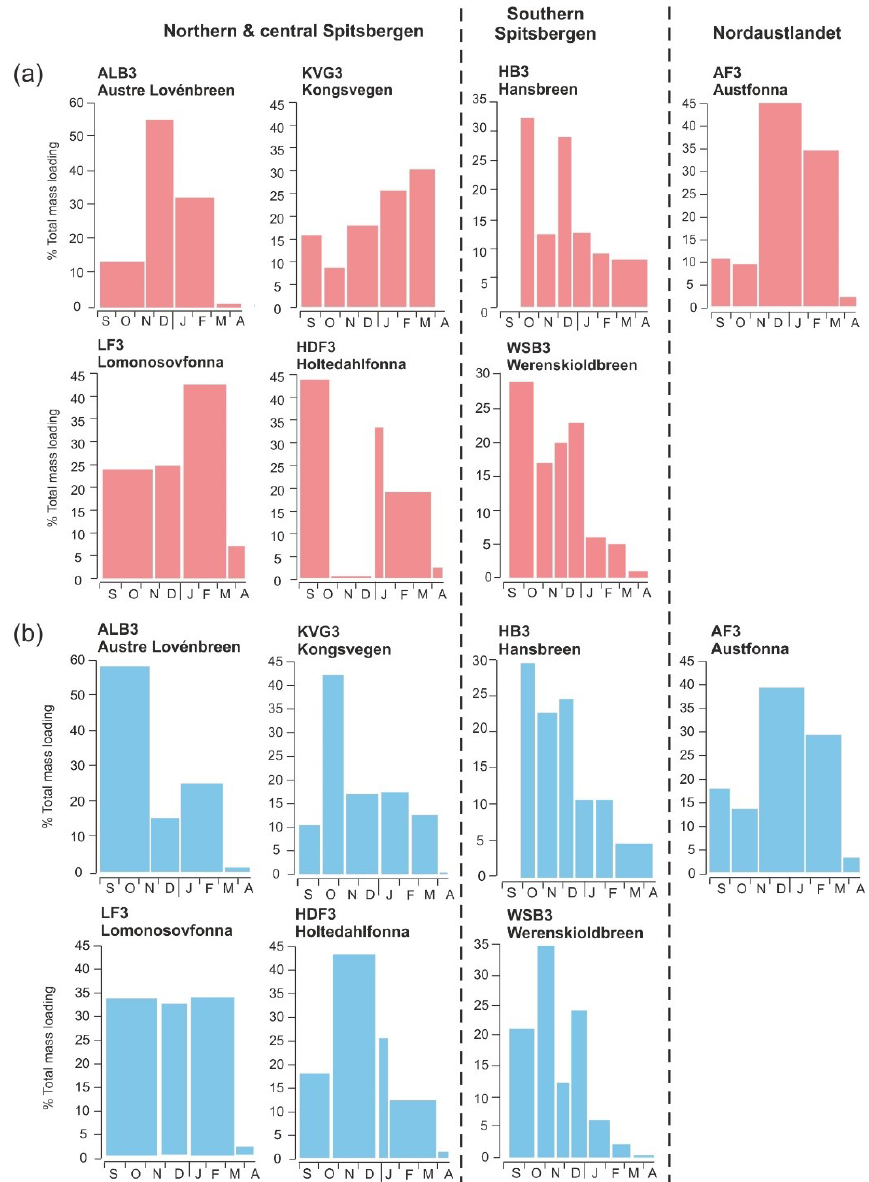
Figure 9. Sub-seasonal increments of (a) L EC snow (red) and (b) L WIOC snow (blue) in the accumulation zone of Svalbard glaciers sampled in spring 2016, as estimated using the snowpack model (e.g., Fig.